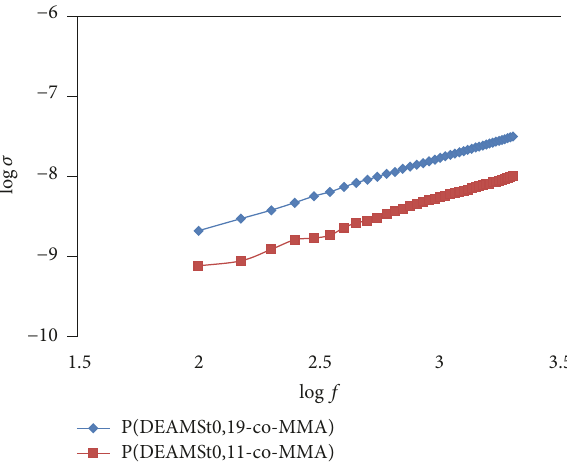
Figure 17: The graph of the conductivity (log 𝜎 ) change with frequency for P(DEAMSt0.11-co-MMA) and P(DEAMSt0.19-co- MMA).